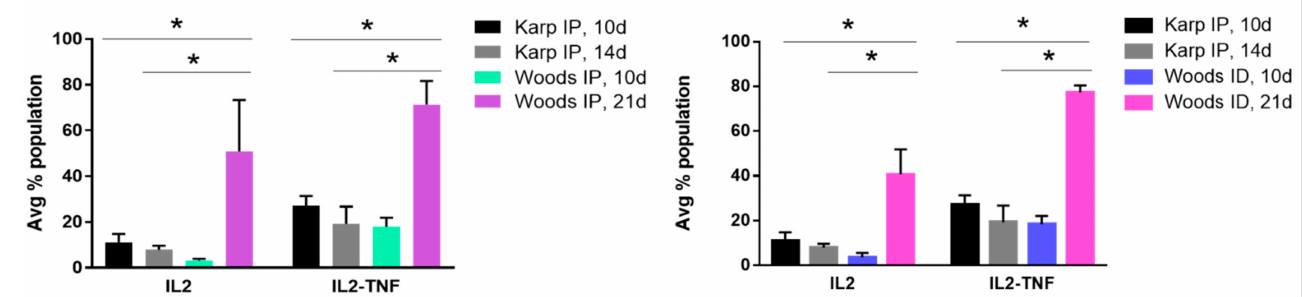
Figure 8. CD4 nonlethal (protective) cytokine signature. Significant differences in IL2 and IL2-TNF cytokine populations were observed in the interstrain comparisons between the lethal and nonlethal models. Significant increases in IL2 and IL2-TNF populations were observed in the nonlethal models at 21 dpi compared to the lethal models at both 10 and 14 dpi. Significant differences between average cytokine populations in the lethal and nonlethal models are indicated by asterisks (*, p < 0.05).